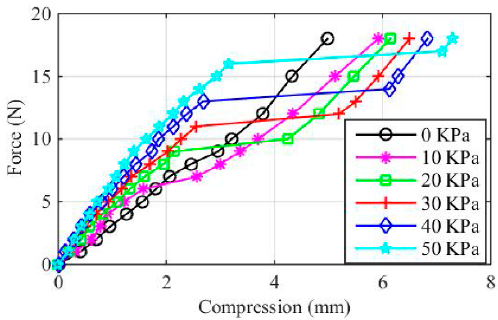
Figure 10. Measured force-compression curves of the PVSU.